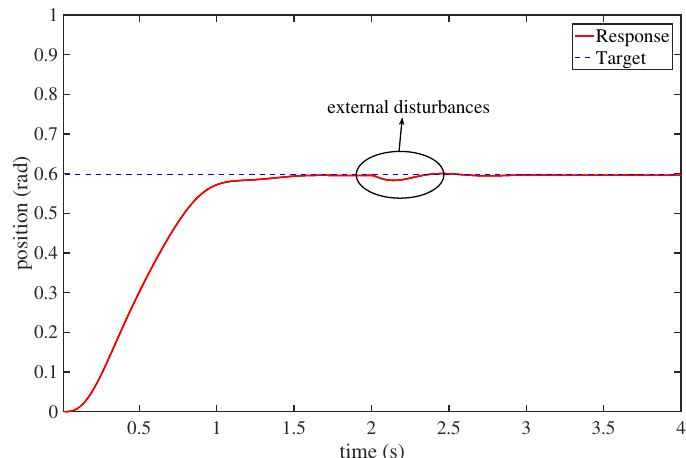
Figure 11. The target tracking process with external disturbances.